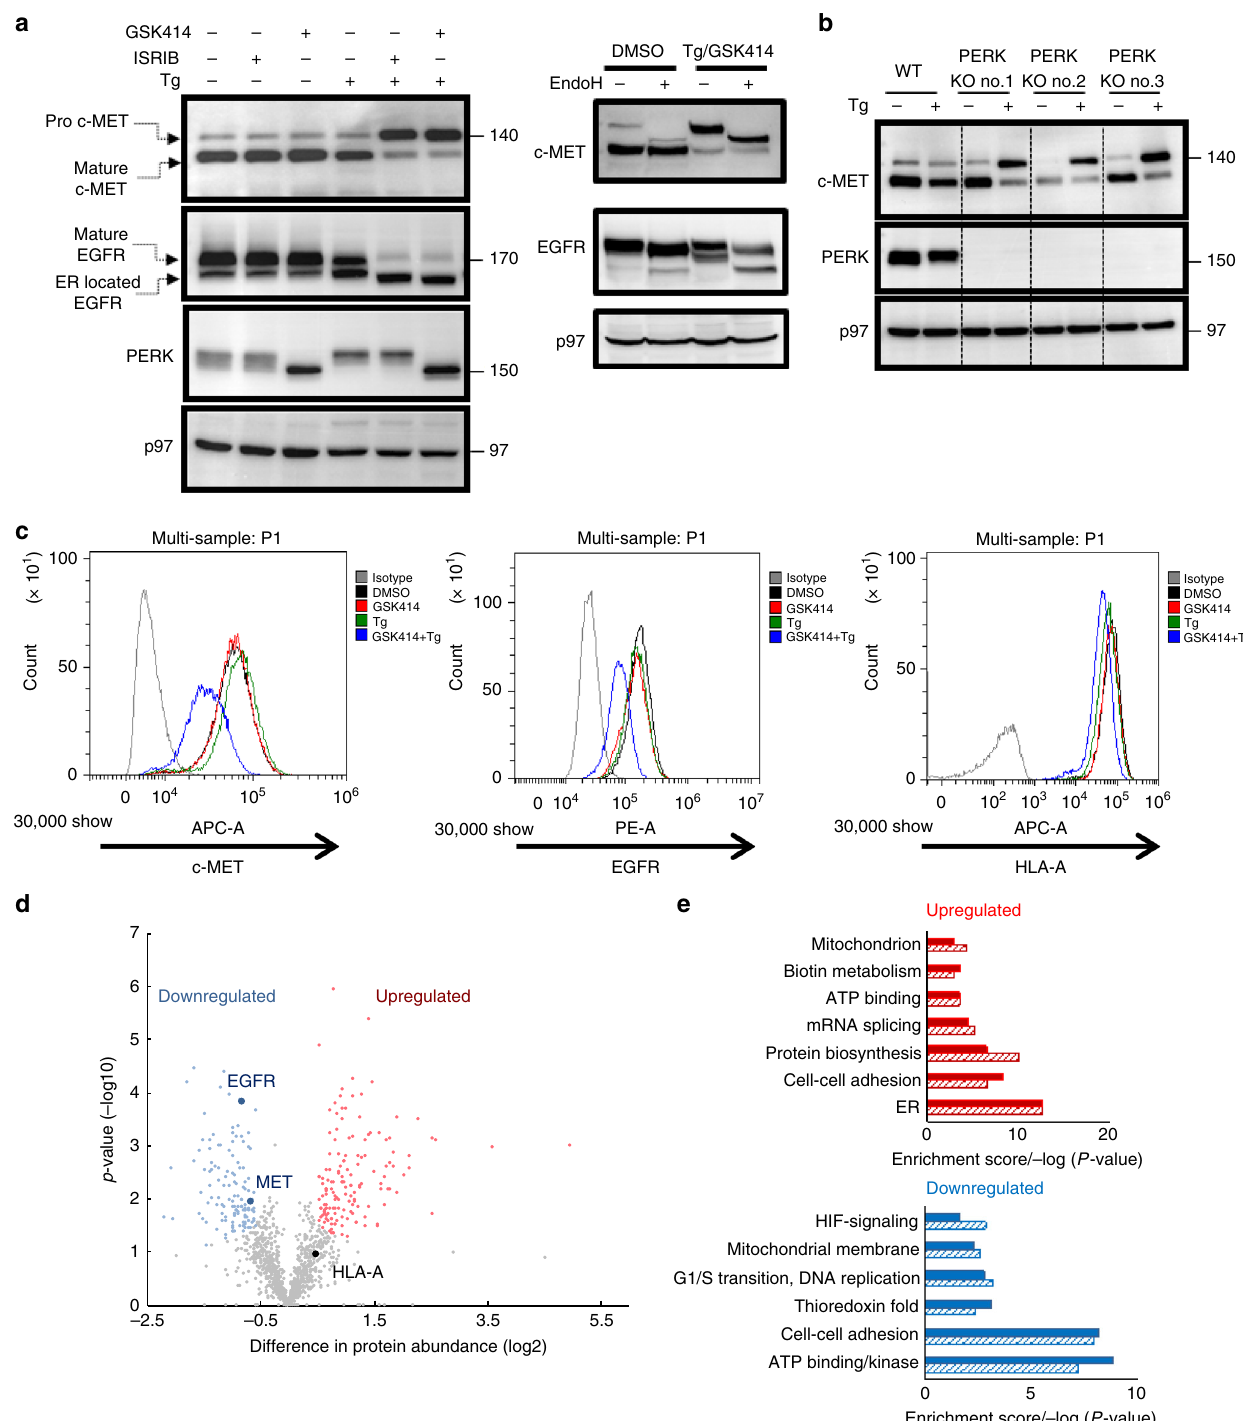
Fig. 2 Impairment of PERK/ISR signaling under ER stress confers the ER retention of a subset of proteins, including prominent oncogenic RTKs. a Immunoblotting and ponceau-s staining as for c-MET, EGFR, PERK, and p97 as loading control in HepG2 cells treated with Tg, GSK414, and ISRIB alone or in combinations for 16 h (typical result of three independent repetitions). b Immunoblotting for c-MET, PERK, and p97 in WT HepG2 and in three different clones of PERK KO HepG2 cells, treated either with DMSO or Tg alone for 16 h; c Flow cytometry analysis of surface c-MET, EGFR, and HLA-A in WT HepG2 treated with DMSO, Tg, and GSK414 for 16 h (typical result of three independent repetitions). d , e Comparative proteomics of the surface proteins upon treatment with Tg in absence and presence of GSK414. The differently expressed proteins shown by the volcano plot ( d ). Signi fi cantly upregulated proteins upon the Tg/GSK414 treatment are in red, the downregulated proteins are in blue, according to the FDR of 0.05 and a fold change greater than two. The volcano plot is related to Supplementary Data Files 1, 2. e Functional enrichment analysis of the upregulated and downregulated proteins affected by the Tg/GSK414 treatment. The enrichment score is above 1.7 (solid bars) with the Benjamini p value < 0.005 (dashed